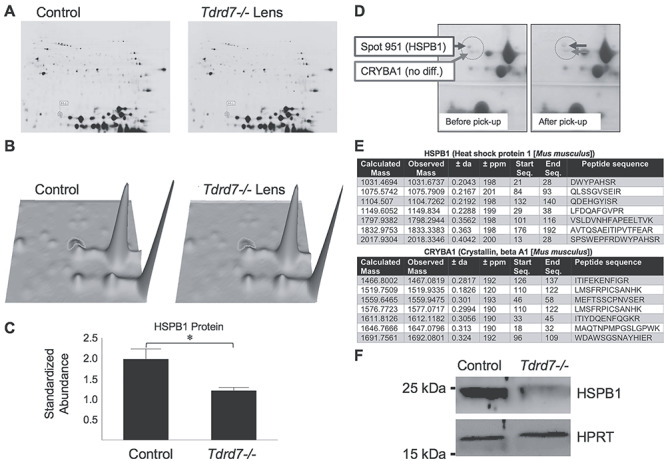
2D-DIGE proteome screen identifies HSPB1 protein to be downregulated in Tdrd7−/− lens. (A and B) 2D-DIGE analysis showed that protein coinciding with ‘spot 951’ was downregulated in Tdrd7−/− lens. (C) Abundance of spot 951 (later identified as HSPB1 protein) was significantly reduced in P15 Tdrd7−/− lens (asterisk represents P-value of 0.039). (D) Spot 951 and a reference spot (later identified as CRYBA1) was picked up for LC-MS/MS-based identification. (E) LC-MS/MS identified spot 951 as mouse HSPB1 with a 100% protein CI as well as a 100% Best Ion CI, while the reference spot was identified as CRYBA1. (F) Western blot confirmed the reduction of HSPB1 protein in Tdrd7−/− lenses compared to control.